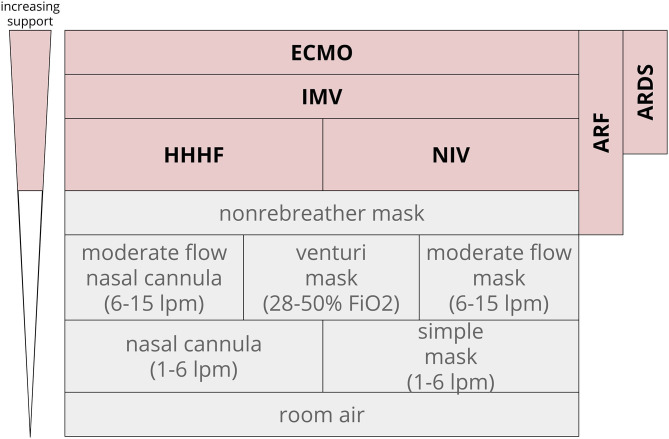
Oxygen support level hierarchy. ARF often incorporates the top four rungs of support. In this diagram, non-rebreather masks often are temporizing measures that lead to escalation to HHHF, NIV, and above. Extracorporeal membrane oxygenation ECMO, invasive mechanical ventilation IMV, heated humidified high flow nasal cannula HHHF, non-invasive ventilation NIV, fraction of inspired oxygen FiO2; acute respiratory distress syndrome ARDS, liters per minute LPM.